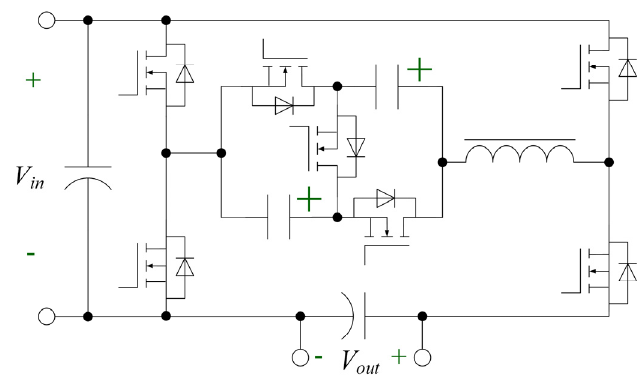
Figure 2. Triple-mode/trisection-mode ZCS SC QR BDC .